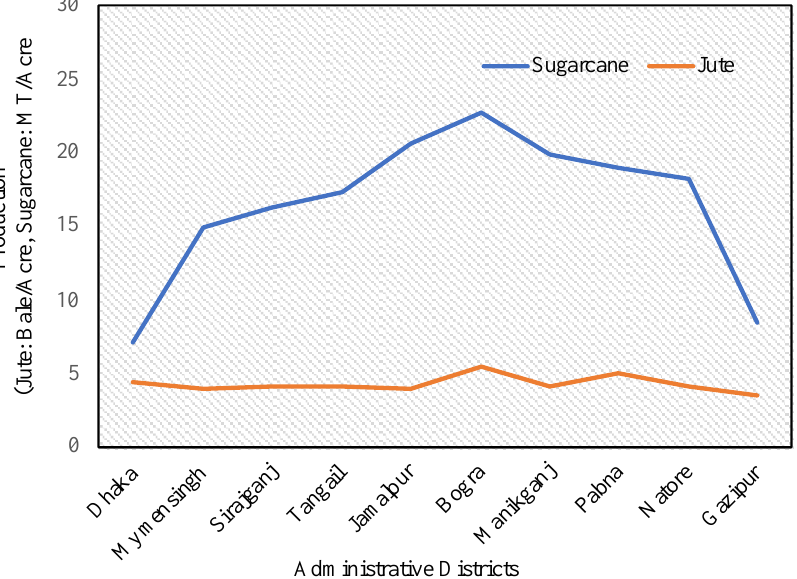
Figure 10. Average production of jute (bale/acre) and sugarcane (MT/acre) in ten administrative districts in Bangladesh during 2021.